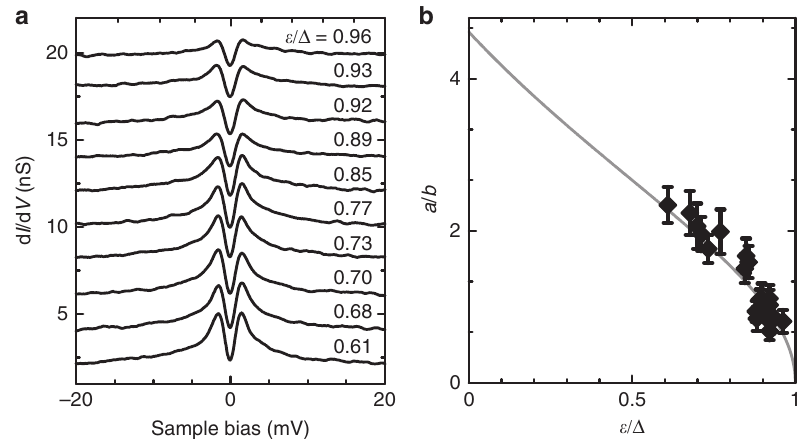
Fig. 4 Kondo scattering versus YSR energy. a Selected d I/ d V spectra of different MnPc – NH 3 complexes ordered according to the YSR energy (50 mV, 200 pA, 500 μ V rms ). Spectra are acquired at B = 2.7 T in order to quench the superconductivity in the Pb-covered tip and the sample. The spectra are offset for clarity. b Amplitude over background a / b as a function of ε / Δ . a / b is extracted from the spectra as in ( a ). ε / Δ as extracted from the spectra at B = 0 T similar to Fig. 1c. Error bars indicate the uncertainty of the read out. For ε , the error is in the order of the symbol size